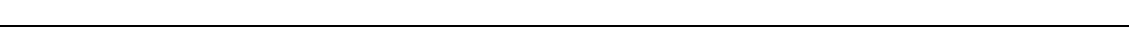
Fig. 4 NOTCH1 is required for maintenance of endothelial cell – cell junctions, cell alignment, and suppression of proliferation under fl ow. Endothelial cells (HAECs) were treated with siRNA for NOTCH1 or Scramble and fl ow-conditioned for 48 h (20 dynes cm − 2 ). a F-Actin and β -catenin revealed gaps between cells as indicated with arrows and in white on inverted image; scale bar = 20 µ m. Cell – cell junctions were quanti fi ed by percent area β -catenin coverage, shown is mean ± SEM from fi ve distinct cultures obtained from fi ve biological replicates. T- test, ****P < 0.0001. b β -Catenin staining to reveal cell shape and determine cell orientation angle (positive value of degrees) with respect to the fl ow direction. At least 70 cells were evaluated per condition across three biological replicates; scale bar = 20 µ m. T- test ****P < 0.0001. c Increased cell density for NOTCH1 KD compared to control by quanti fi cation of nuclei counts; scale bar = 20 µ m. Graphs show data obtained from four biological replicates, > 100 cells per replicate, and expressed as mean ± SEM. T- test ****P < 0.0001. d CCND1 transcript was analyzed in HAECs cultured statically or fl ow-treated with 50 µ M DAPT or volume equivalent DMSO for 24 h by NanoString nCounter Gene Expression. Graph bars represent mean ± SEM, n = 5. T- test **P < 0.01, ****P < 0.0001. e CCND1 transcript is increased after blocking NOTCH1 signaling for HAEC monolayers that were fl ow-aligned for 48 h and subsequently treated with DAPT or vehicle under fl ow for an additional 12 h. Graph bars represent mean ± SEM, n = 5. T- test *P < 0.05. f Monolayers were subjected to fl ow for 24 h with 50 µ M DAPT or vehicle and protein lysates analyzed by immunoblot to quantify expression of γ -H2A.X to show a 2.7-fold increase in γ -H2A.X expression for DAPT treated cultures ( n = 4, T- test **P < 0.01). g NanoString nCounter Gene Expression for EFNB2 , KLF2 , and KLF4 transcripts for HAECs cultured under fl ow for 24 h in the presence of 50 µ M DAPT or DMSO revealed reduction in transcripts for EFNB2 , but no statistically signi fi cant change for KLF2 or KLF4 . Graph bars represent mean ± SEM, n = 5. T- test ****P <